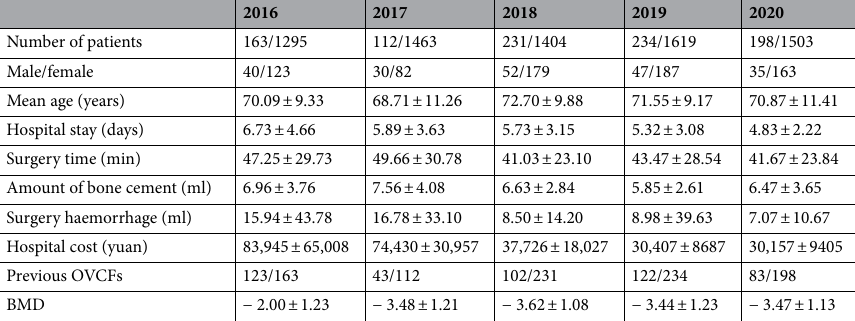
Table 1. Basic information of OVCF patients over 5 years.